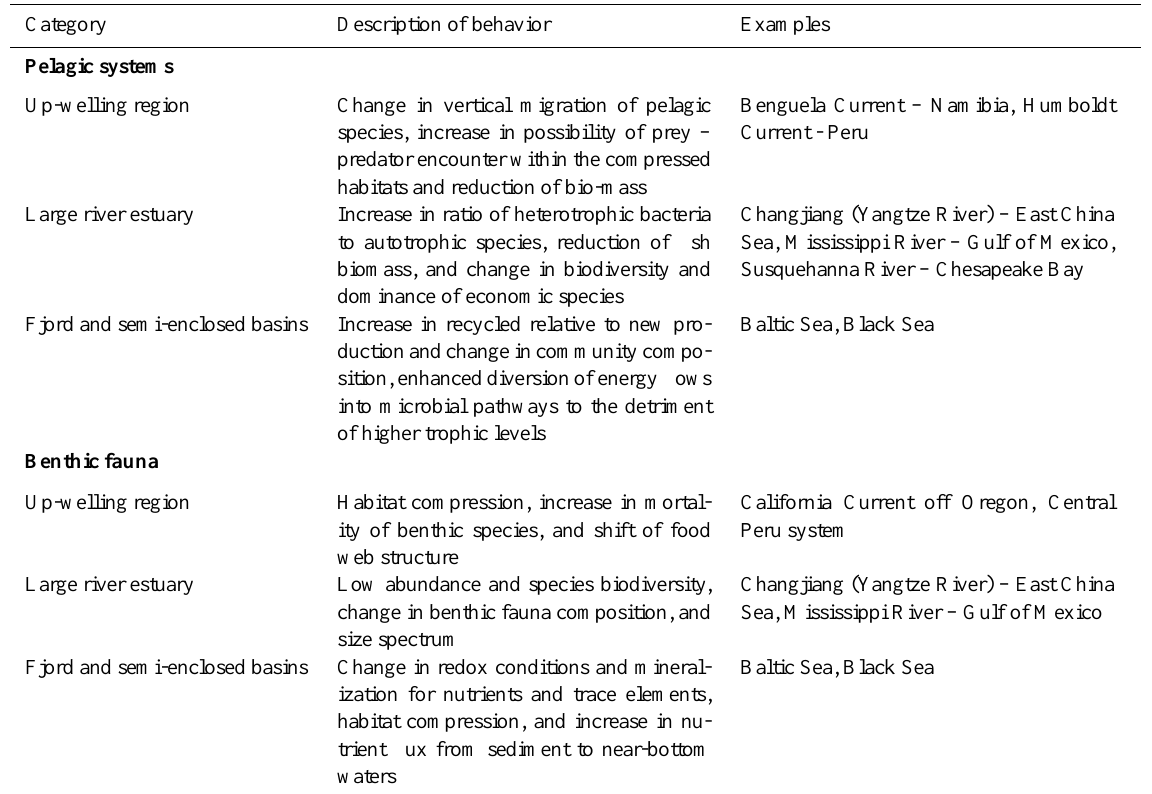
Table 1. Comparison of behaviors of biota in marine areas affected by coastal